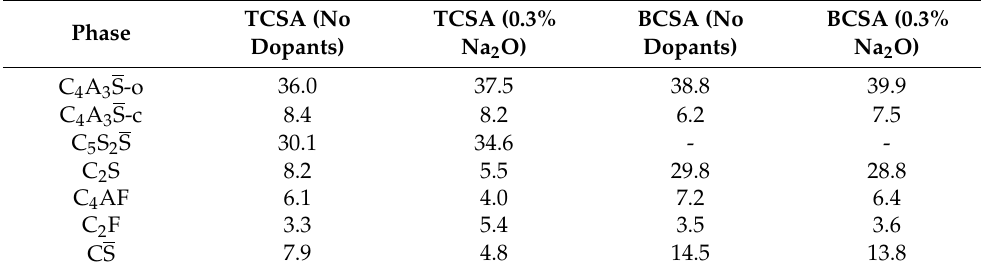
Figure 8. Rietveld refinements for the TCSA cement clinker with 0.3% Na 2 O, R wp = 8.55. Table 8. Quantitative mineralogical compositions of the TCSA and BCSA clinkers (wt.%).